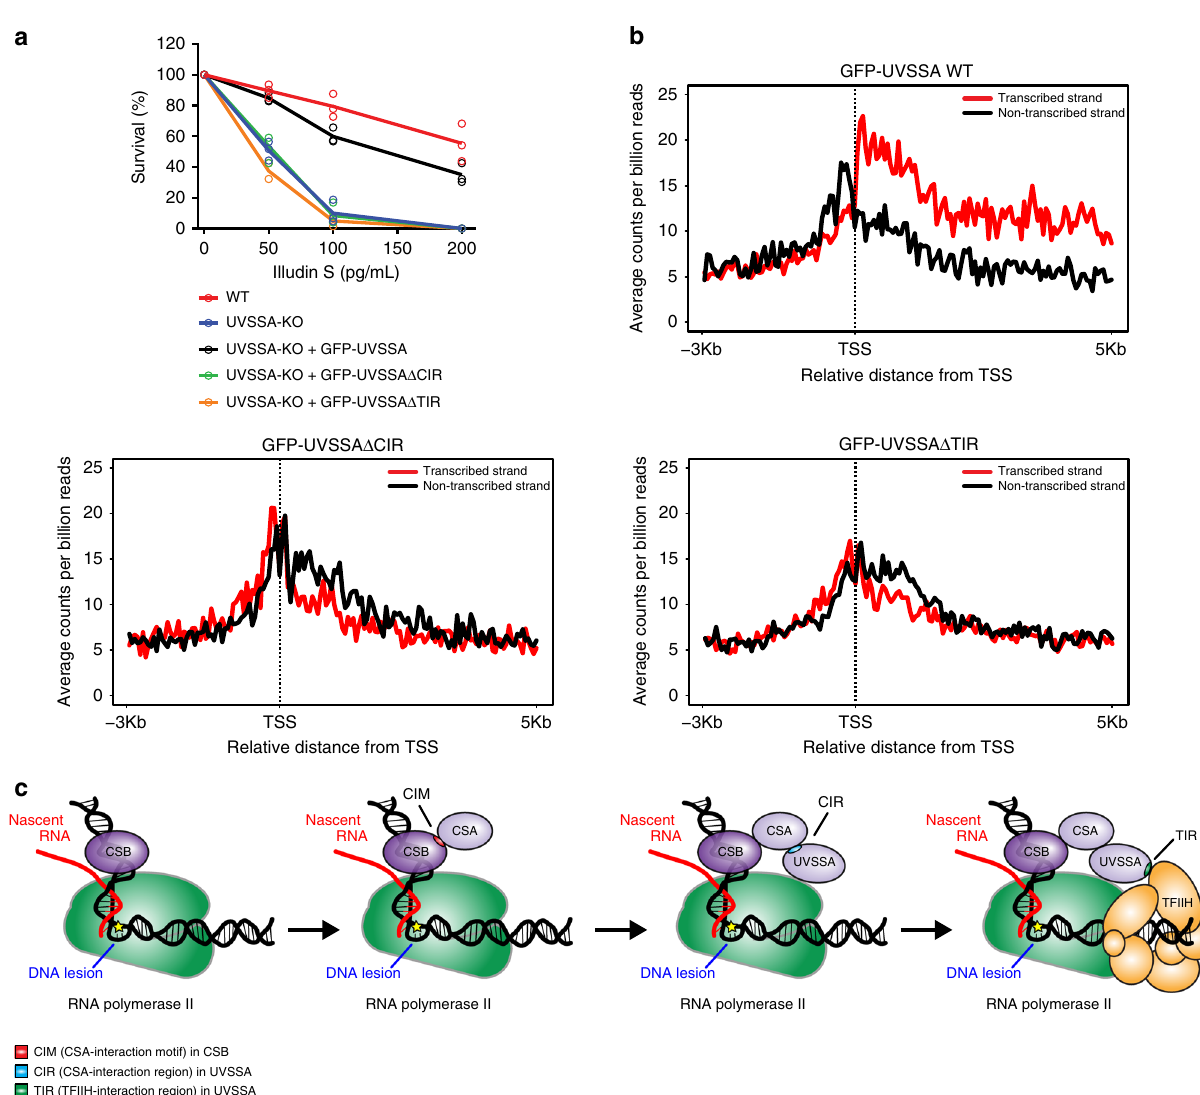
Fig. 7 The CIR and TIR of UVSSA are crucial for TCR. a Clonogenic Illudin S survival of WT and UVSSA-KO cell lines and the GFP-tagged UVSSA rescue cell lines. Each symbol represents the mean of an independent experiment ( n = 3 for all except for GFP-UVSSA Δ CIR which is n = 2), each of which is based on two technical replicates. Note that the same survival data for UVSSA-KO is also shown in Fig. 4b. b CPD XR-seq repair signal 3 Kb upstream and 5 Kb downstream of the annotated TSS of 16,088 genes in GFP-UVSSA WT , GFP-UVSSA Δ CIR , and GFP-UVSSA Δ TIR . Signal is plotted separately for the transcribed (red) and non-transcribed (black) strands. The data represent the average of two independent experiments for GFP-UVSSA WT and one single experiment for GFP-UVSSA Δ CIR and GFP-UVSSA Δ TIR with a bin size of 53 nt. See also Supplementary Fig. 9 for additional XR-seq data. c Model of how the assembly of CSB, CSA, and UVSSA targets the TFIIH complex to DNA damage-stalled RNAPIIo. Source data are provided as a Source Data fi